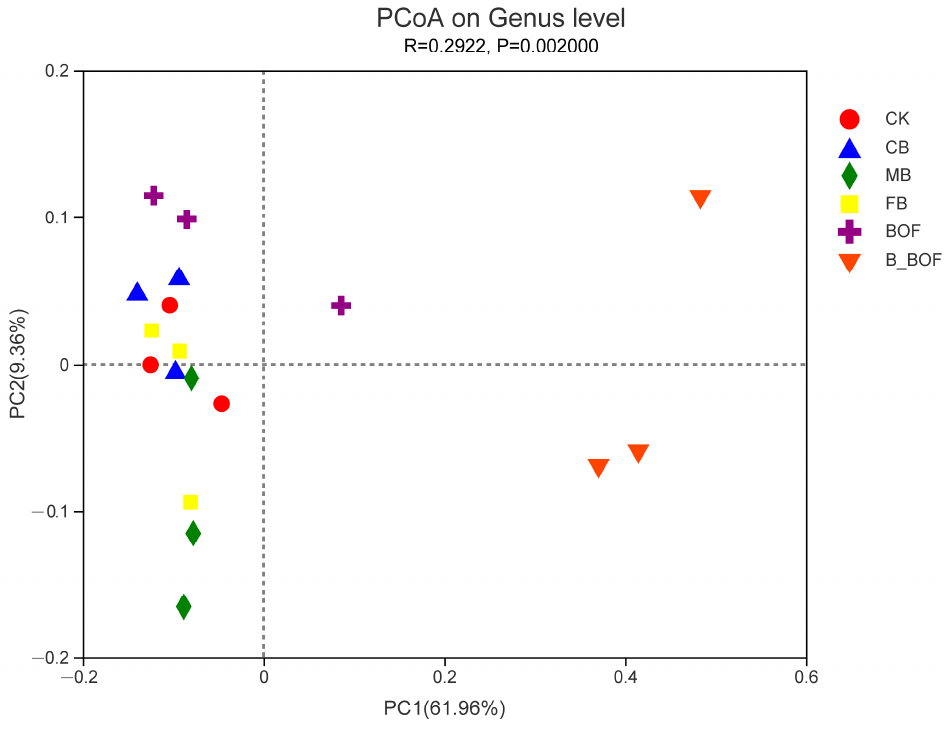
Figure 6. PCoA plot of the relationship between the samples based on similarity in the community composition. Two first components (PCoA 1 and PCoA 2) were plotted and represent 71.32% of the variation.